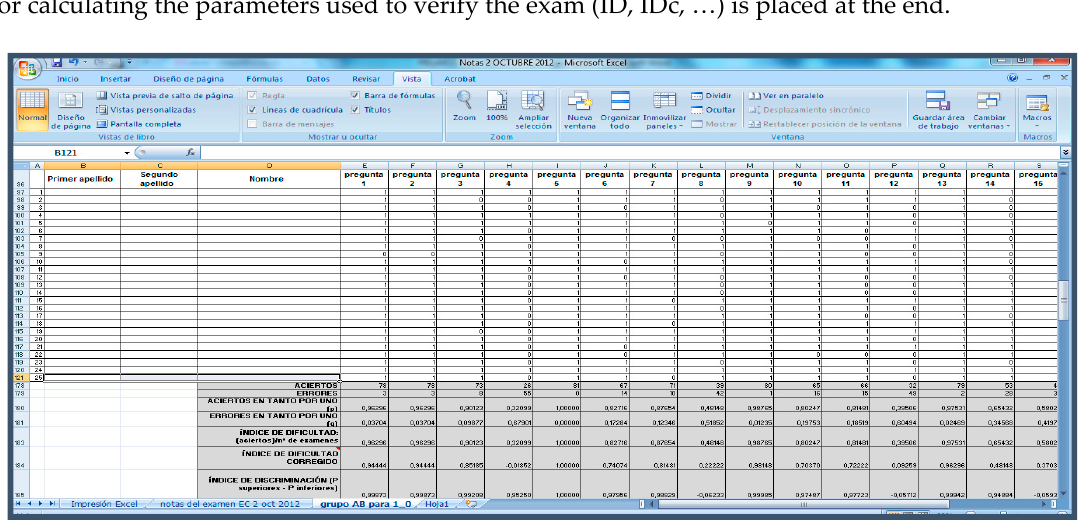
Figure 1. Excel sheet showing the values of the evaluating parameters for an